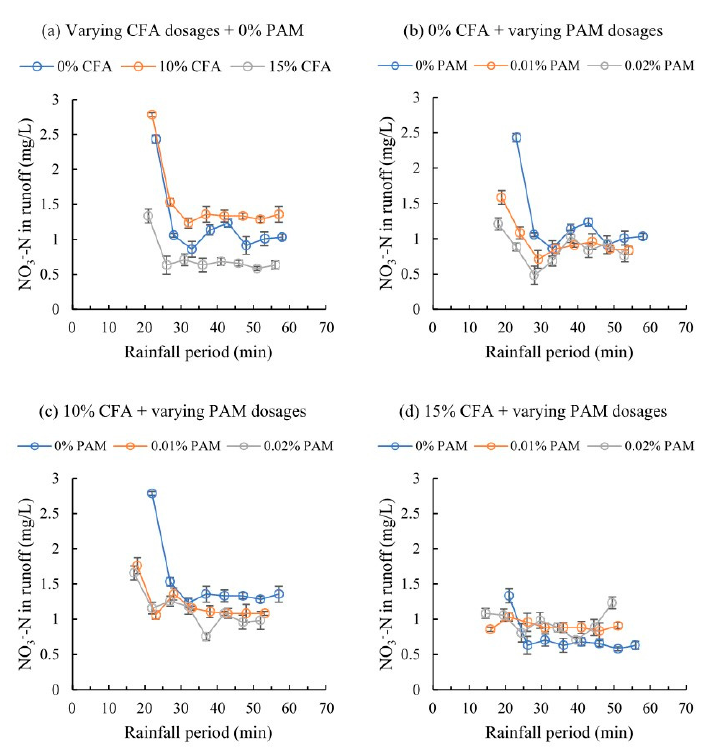
Figure 2. Variations in instantaneous NO 3 − -N concentration in runoff with rainfall period for varying CFA dosages + 0% PAM ( a ), 0% CFA + varying PAM dosages ( b ), 10% CFA + varying PAM dosages ( c ), 15% CFA + varying PAM dosages ( d ).